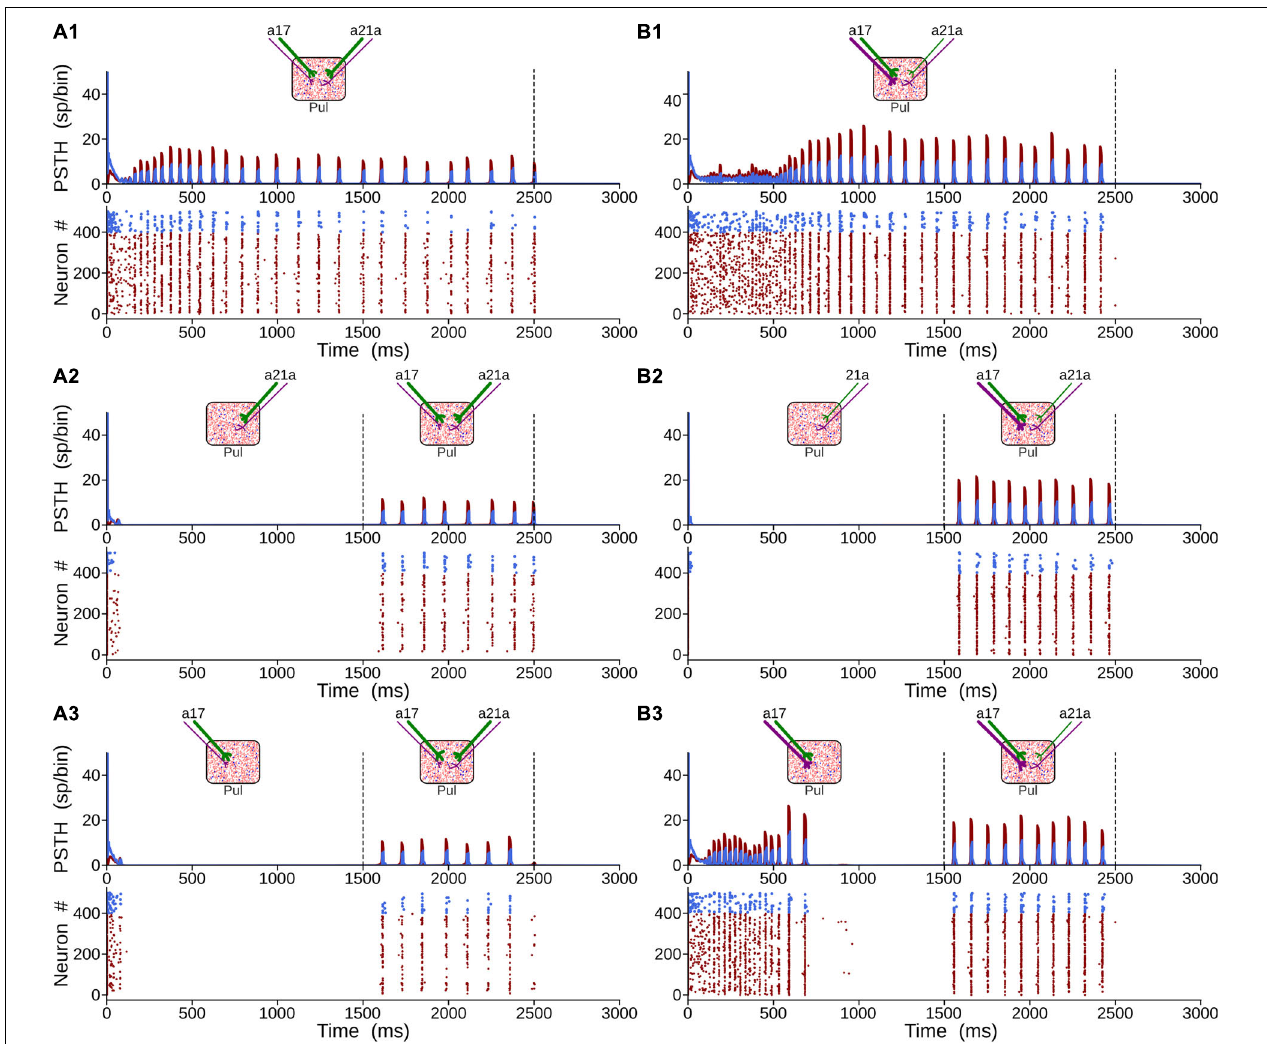
FIGURE 8 | Generation of alpha waves by the combination of the two CT projections. (A) Solution when type 2 terminals (purple axons) are weaker than type 1 (green axons). (B) Solution when terminal types 1 and 2 from area 17 are stronger than connections from area 21a. For panel (A) , η a 17 1 = η a 21 a 1 = 0.3 and η a 17 2 = η a 21 a 2 = 1.8. For panel (B) , η a 17 1 = η a 17 2 = 2.0 and η a 21 a 1 = η a 21 a 2 = 0.5.